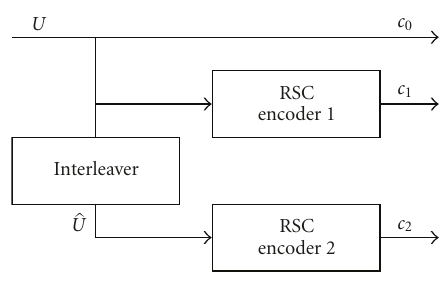
Figure 2: Framework of turbo encoder.